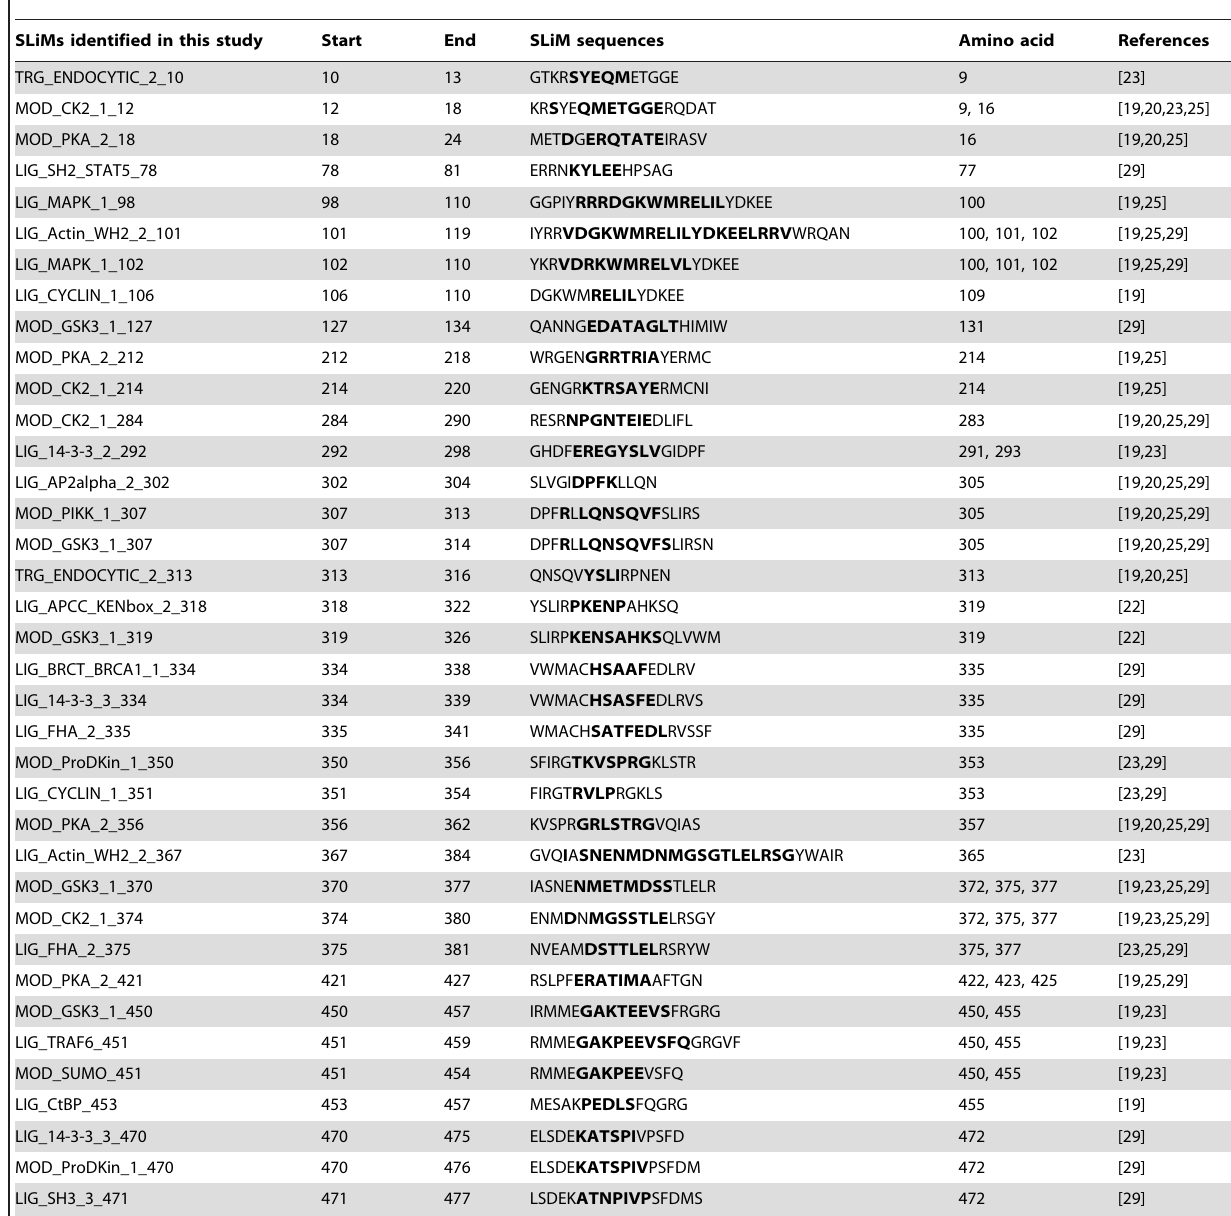
Table 5. SLiMs mapped to the vicinity of amino acids that were reported as genetic signatures or are associated with the adaptation of IAV NP proteins to the